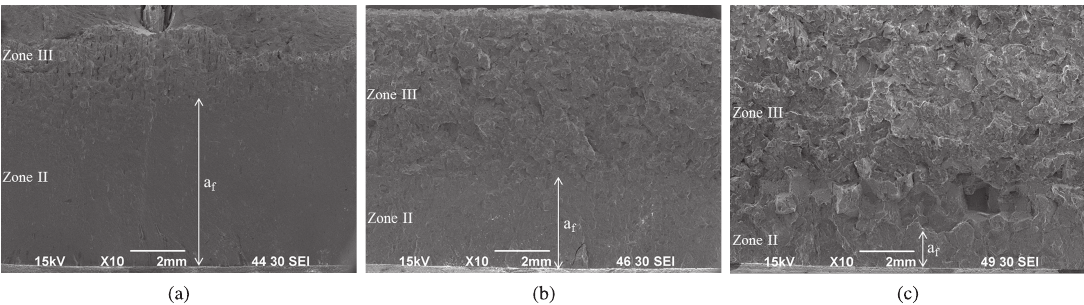
Figure 6. Fractography of fatigue fractured surfaces for HAZ specimens: (a) the highest critical crack size on the as-received condition, (b) normalized for 5 hours with lower crack size, and (c) normalized for 10 hours with the lowest crack